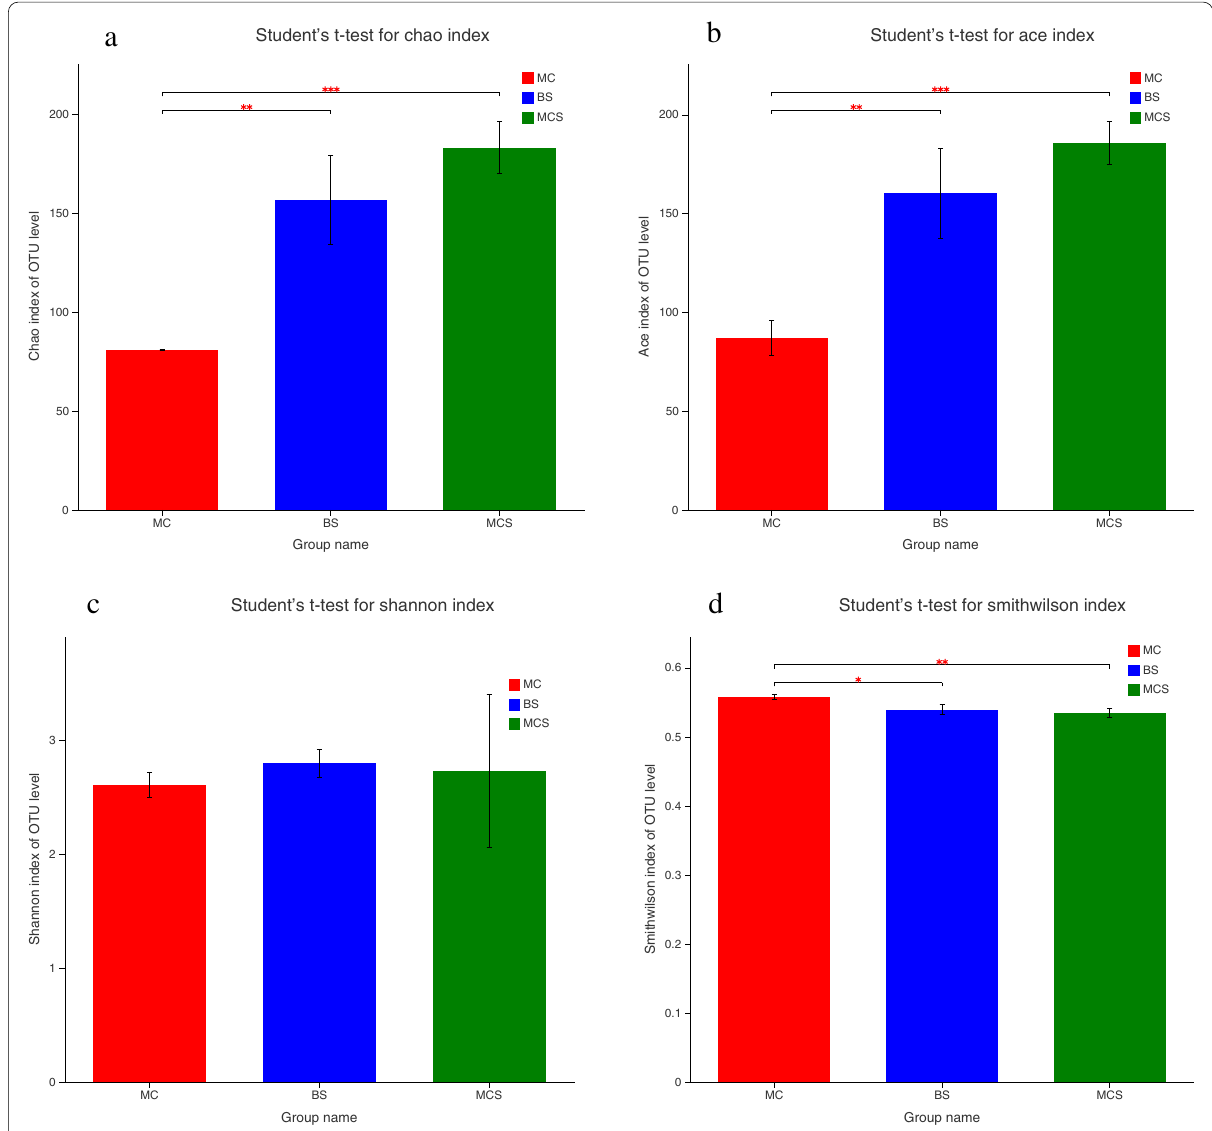
Fig. 2 Histogram of a Chao, b Ace, c Shannon, and d Smith‑Wilson between different amounts of biochar added. Notes: MC, BS, and MCS are the same as in Fig. 1. * P 0.05, ** P 0.01, *** P ≤ ≤ ≤